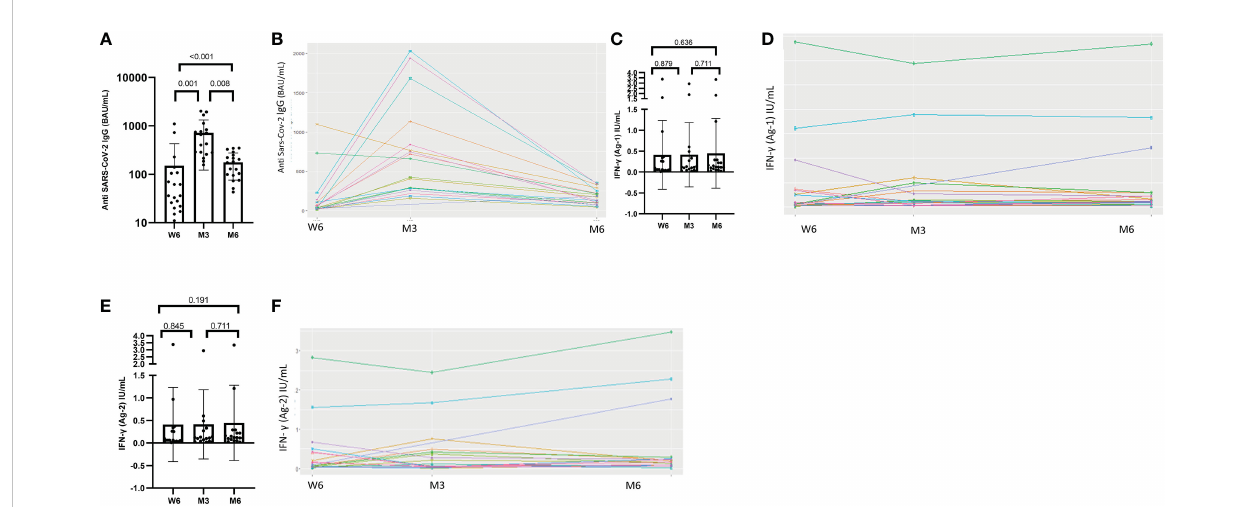
FIGURE 1 Dynamics of humoral response and values of IFN- g secretion after exposure to antigen 1 or antigen 2 at Week-6 (W6), Month-3 (M3) and Month-6 (M6) after administration of BNT162b2 vaccine. (A) Humoral quantitative anti-SARS-CoV-2 IgG antibodies at Week-6 (W6), Month-3 (M3) and Month-6 (M6) generated by the BNT162b2 vaccine. Median anti-SARS-CoV-2 IgG at W6, M3 and M6 were 36 BAU/mL [24-107], 542 BAU/mL [282- 821], and 174 BAU/mL [97-235], respectively (p<0.001). Median anti-SARS-coV-2 IgG antibodies increased signi fi cantly between W6 and M3 (p = 0.001) and decreased at M6 (p=0.008). (C) The median IFN- g level after exposure to Ag1 did not change from W6 to M3, W6 to M6 and M3 to M6, p=0.879, p= 0.636, p= 0.711, respectively. (E) The median IFN- g level after exposure to Ag2 did not change from W6 to M3, W6 to M6 and M3 to M6, p=0.845, p= 0.191, p= 0.711, respectively. (B, D, F) longitudinal result with the paired representation. Test: Wilcoxon Mann-Whitney